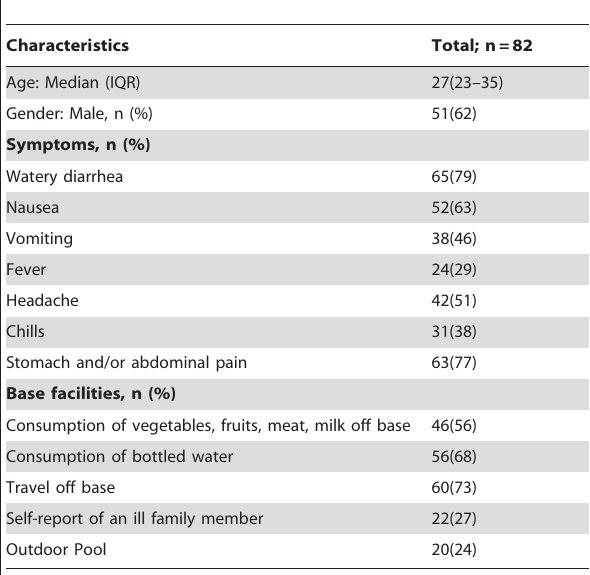
Table 1. Characteristics and activities of gastroenteritis cases reported by case-based surveillance survey responders.